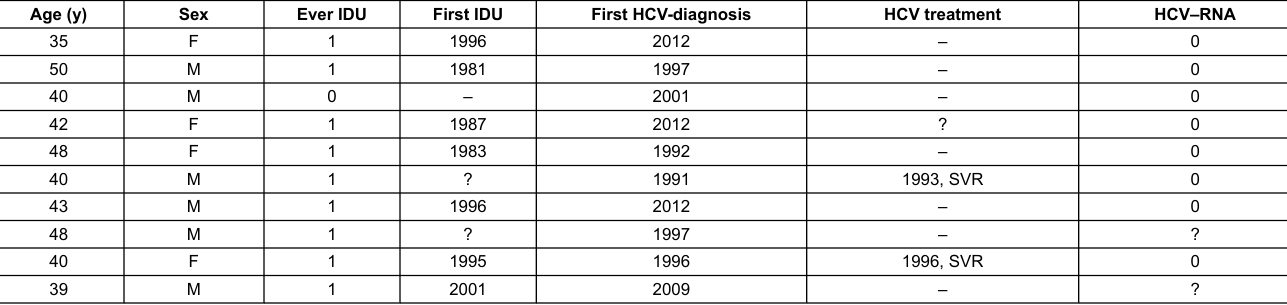
Table 4: Characteristics of the 10 patients with false negative HCV rapid tests. Age (y)